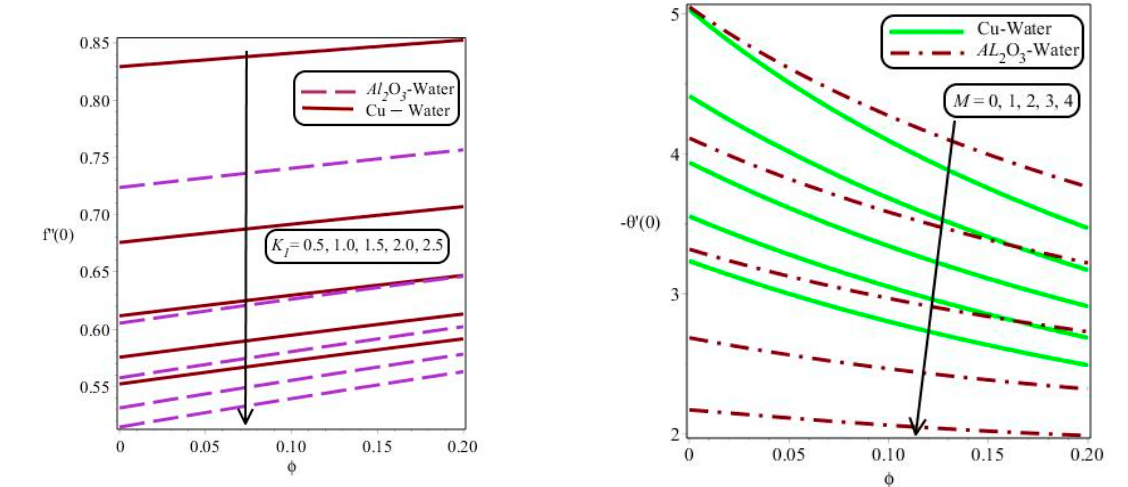
Figure 11. ( a , b ) Impact of M and K f on surface force and temperature gradient with β = 0.7, N = 0.5, K 1 = 0.7, and M =